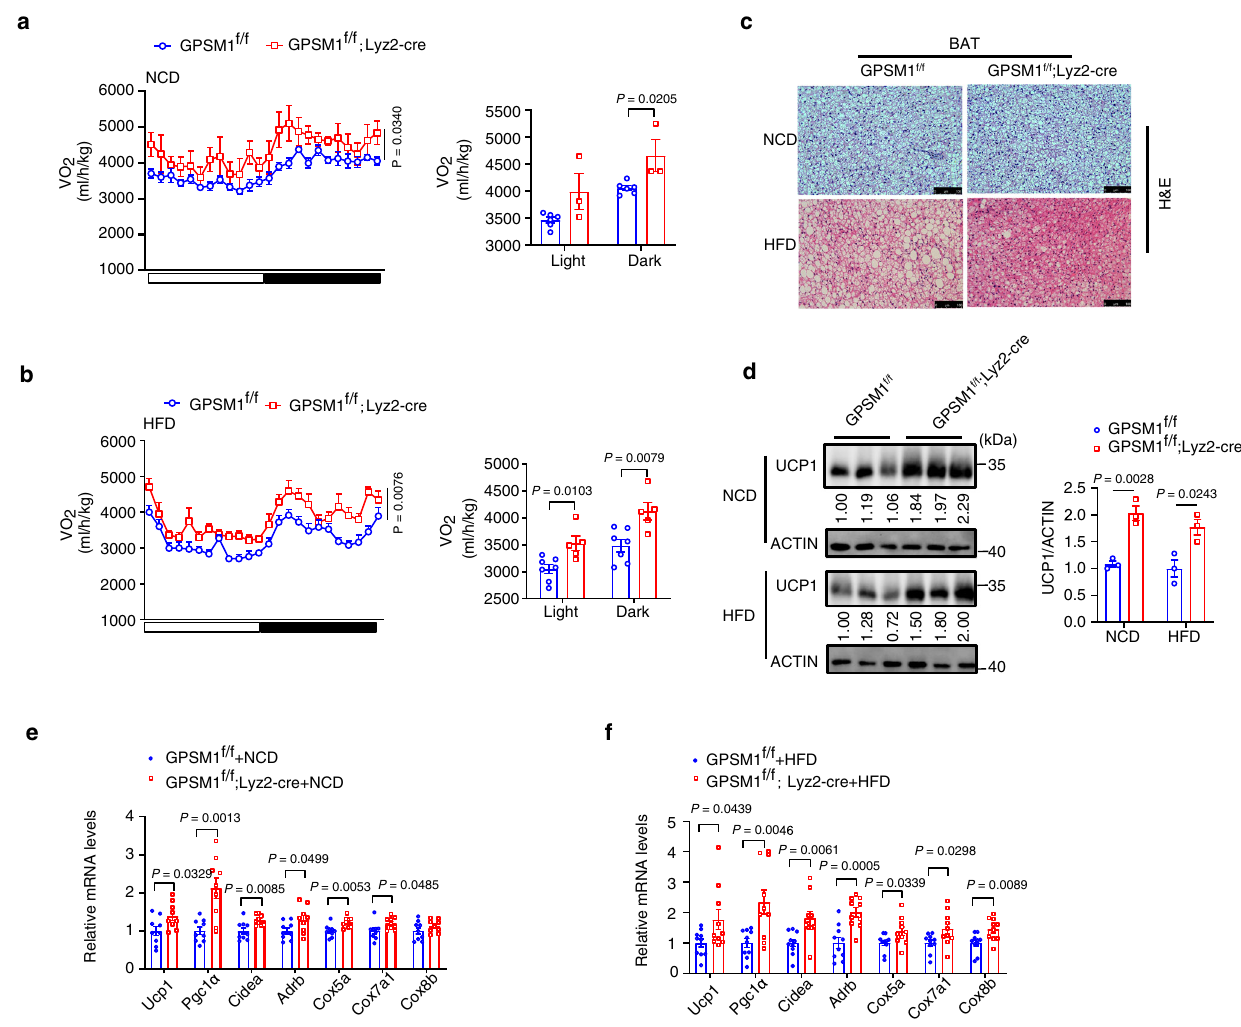
Fig. 4 | GPSM1 de fi ciency in macrophages increases energy expenditure. a , b Oxygen consumption (VO 2 ) monitored over a 24-h period and shown as averagedvaluesinNCD-fed( a , n =6biologicallyindependentmicefor GPSM1 f/f and n =3 biologically independent mice for GPSM1 f/f ; Lyz2 -cre) and HFD-fed ( b , n =7 biologicallyindependentmicefor GPSM1 f/f and n =5biologicallyindependentmice for GPSM1 f/f ; Lyz2 -cre). c Representative images of H&E staining of BAT sections. Scalebars,100 μ m. d ImmunoblotsofUCP1inBATandquanti fi cation(right), n =3